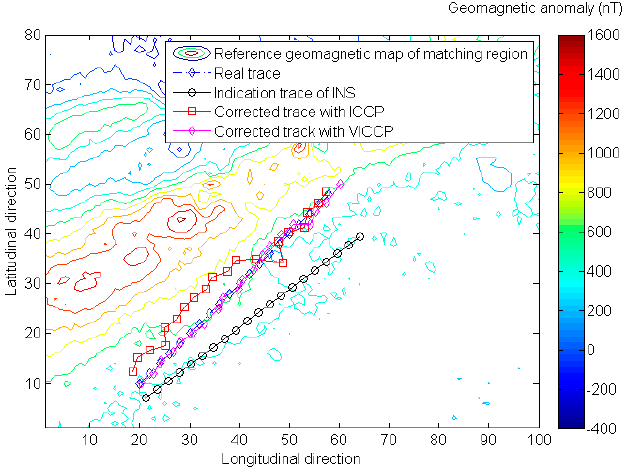
Table 3. Comparison of ICCP and VICCP with 100 times Monte Carlo simulation. Figure 3. The comparison of geomagnetic matching results with iterative closest contour point (ICCP) and vector iterative closest contour point (VICCP). Note that the indication trace of INS does not contain scale error in this